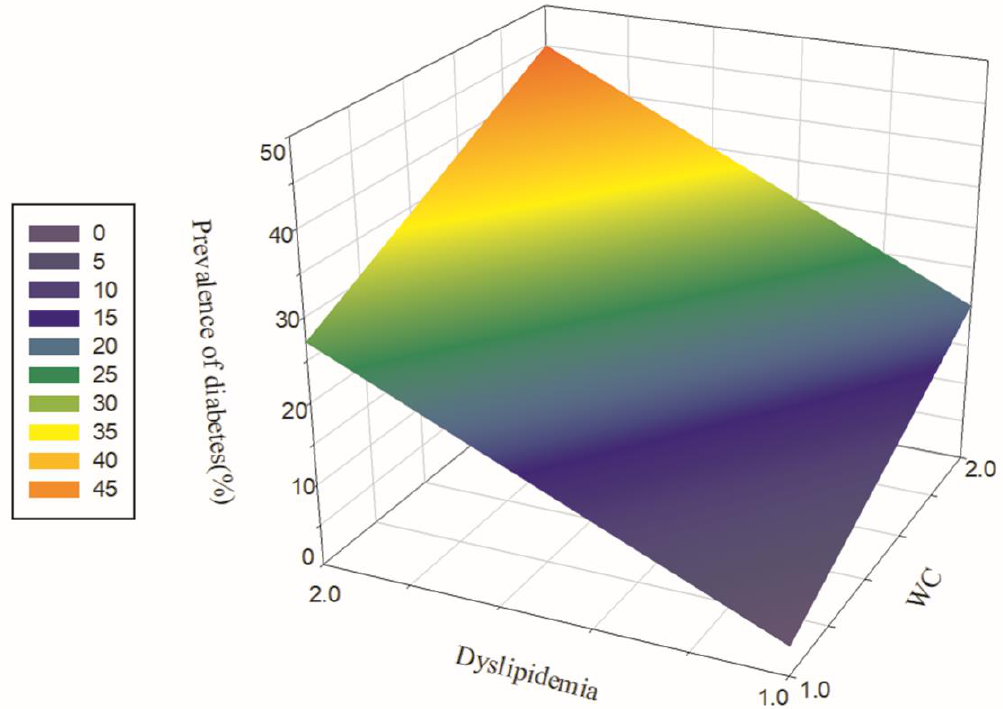
Figure 4. Relationship amongst dyslipidaemia, abdominal obesity and the prevalence of diabetes.